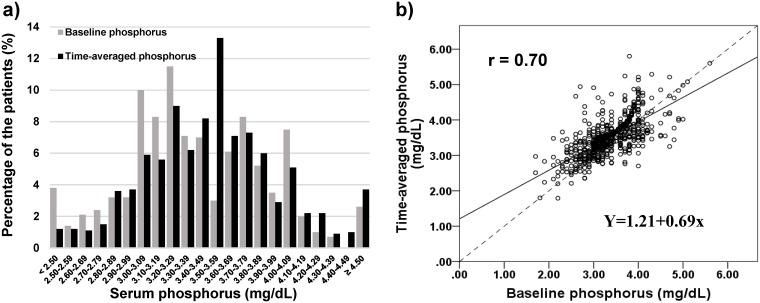
Baseline phosphorus and time-averaged phosphorus in the follow-up.a) The distribution of the baseline phosphorus and TA-P. The number of patients decreased below 3.5 mg/dL of serum phosphorus while the percentage dramatically increased in the range of 3.50–3.59 mg/dL of time-average phosphorus. Hyperphosphatemia accounted for 2.6% and 3.7% at baseline and in the follow-up, respectively. b) The relationship between TA-P and baseline phosphorus. A regression line is depicted in black line and a unity of the slope is overlapped in a dotted line. The correlation coefficient was 0.69 (p < 0.001). Two lines converge at 3.9 mg/dL of phosphorus. TA-P increased below baseline phosphorus 3.5 mg/dL and decreased above baseline phosphorus 3.5 mg/dL due to the remarked increase in distribution as shown in a). Abbreviation: TA-P, time-averaged phosphorus.